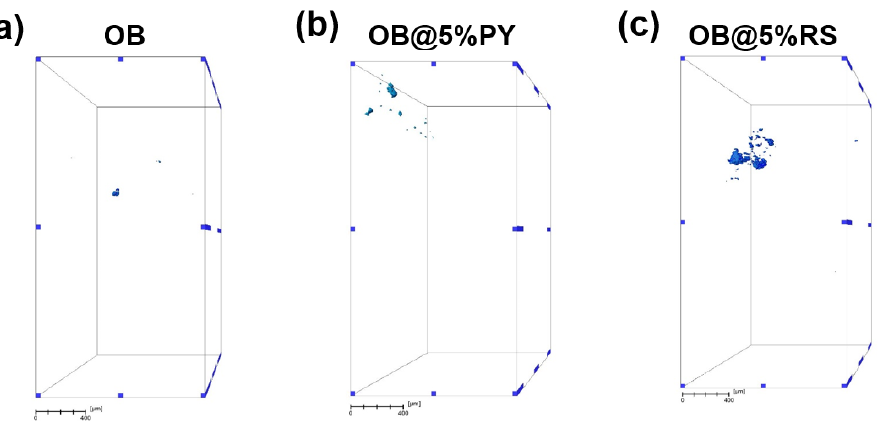
Figure 9. Micro-computed X-ray tomography analysis (scale bar of 400 µm). Volume rendering of the segmented pores in ( a ) OB (unmodified sealer); ( b ) OB@5%PY (sealer doped with 5%PY); and ( c ) OB@5%RS (sealer doped with 5%RS). Table 4. Pore characteristics of OB, OB@5%RS and OB@5%PY as calculated from µCT imaging. Group